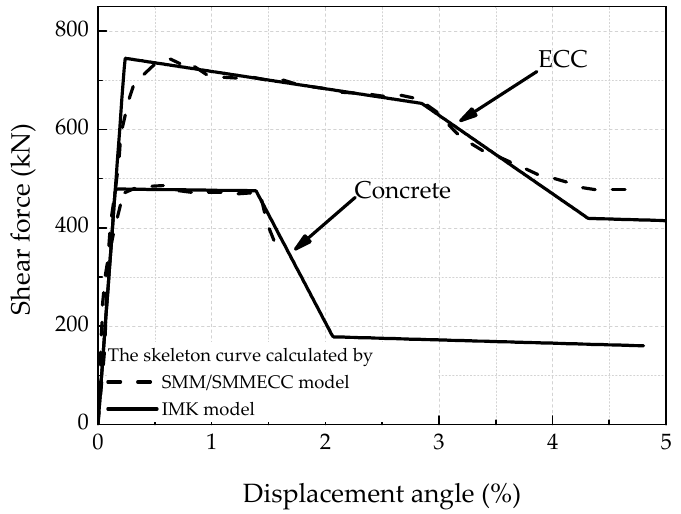
Figure 8. Skeleton curves of the RC short column and ECC short columns simulated by two models.